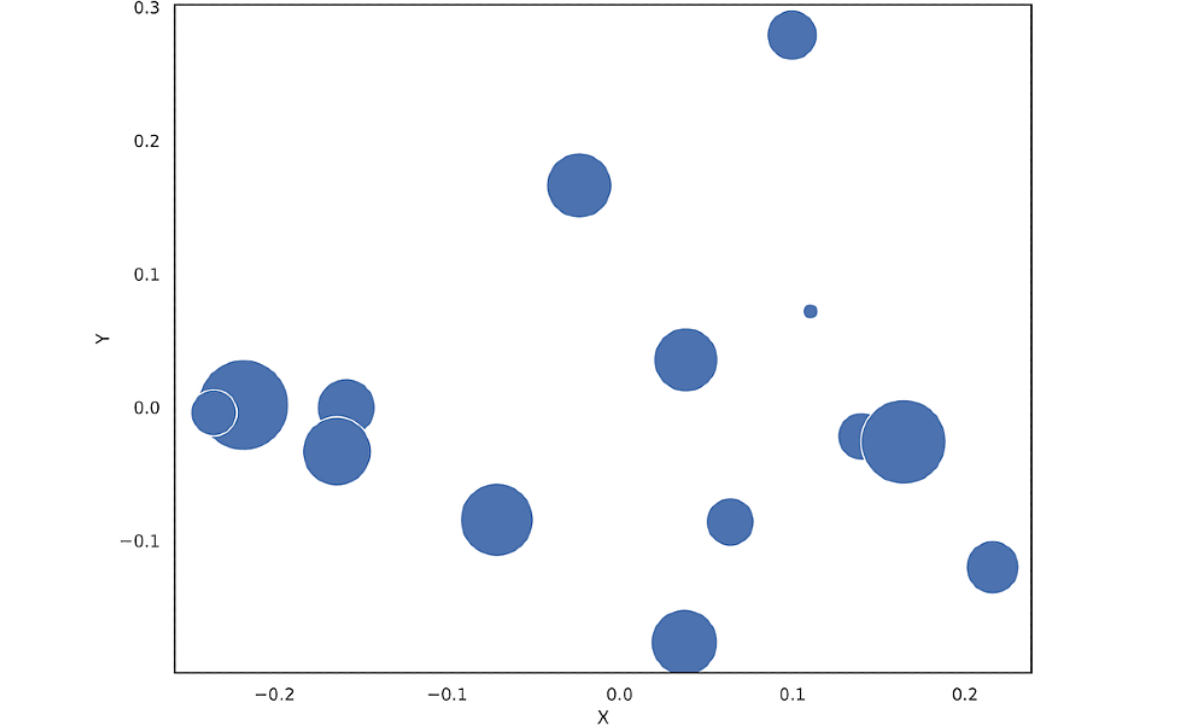
Figure 3. Principal component analysis plot for the chosen latent Dirichlet allocation model with 14 topics. Overlaps are seen for three topic clusters; however, these topics were found to be separated by clinical